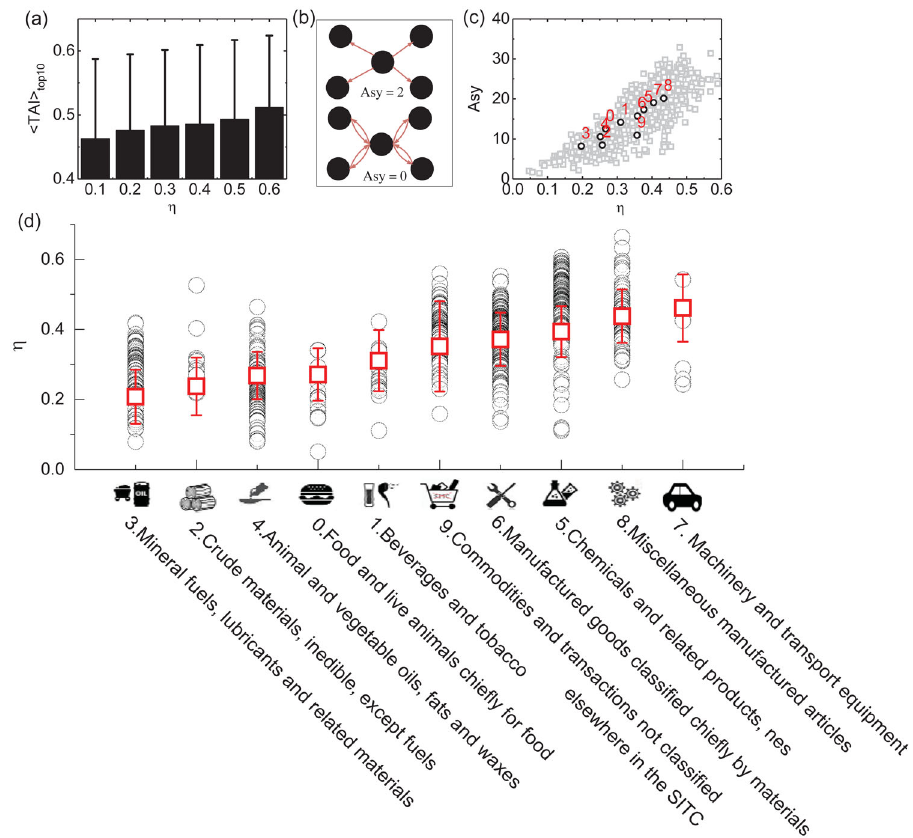
Fig. 2 Detection of product complexity. a The countries with advanced technologies in a nested matrix. We use the TAI index to measuring the technology achievement of nations (Desai et al., 2002; Nasir et al., 2011). The higher TAI indicates the higher national technological capability of a country. < TAI > top10 is the mean TAI of the countries with the top 10 out-degree in each layer. b The asymmetry of a network that characterizes the dispersion between the node ’ s indegree and outdegree. The asymmetry of a directed network is 2, but the asymmetry of an indirected network is 0. c The asymmetry of nested networks. Gray points correspond to 786 products. Bright points are the mean asymmetry of the products belonging to different sectors. Red numbers correspond to sector numbers in sub fi gure ( d ). d Red points are the mean nestedness value of products from ten sectors classi fi ed according to the SITC code (detailed introduction seen in Supplementary Table S3). Black points are nestedness value of 786